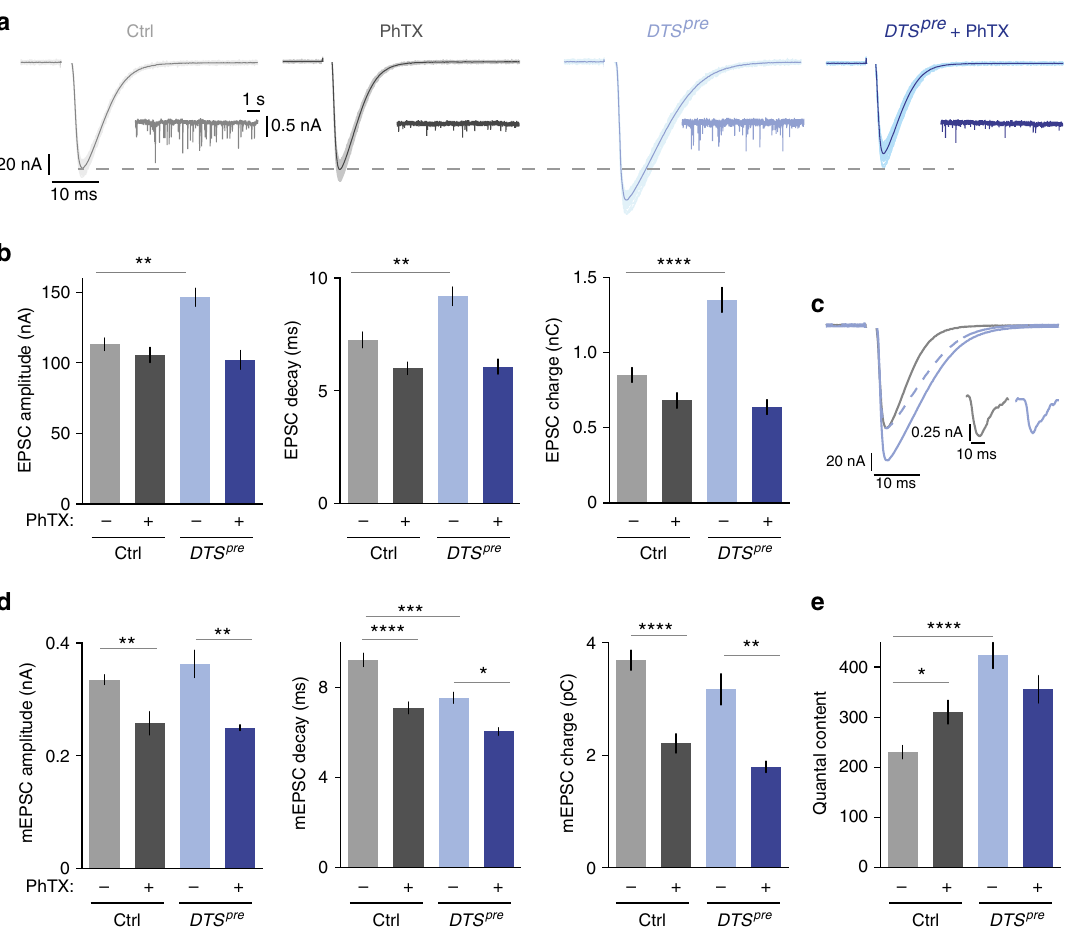
Fig. 4 Presynaptic proteasome perturbation increases EPSC amplitude and decay time. a Two-electrode voltage-clamp recordings of DTS pre mutants and controls with or without PhTX application (20 – 30 µ M; 1 mM [Ca 2+ ] e ). Representative EPSCs (50 sweeps per cell; the average is displayed in darker color; stimulation artifacts have been blanked for clarity) and mEPSCs are shown. b Quanti fi cation of the experiment shown in ( a ). Note that presynaptic proteasome inhibition leads to an increase in EPSC amplitude, decay time constant and charge. Moreover, proteasome inhibition blocks homeostatic plasticity in response to PhTX application. Mean ± s.e.m.; n ≥ 10 cells; ** p < 0.001; **** p < 0.00001; ANOVA and Tukey ’ s multiple comparison tests. c Overlay of an average EPSC of a control cell (gray) and after proteasome inhibition (blue; DTS pre ). The dashed line shows the EPSC for DTS pre normalized to the EPSC amplitude of control. Inset: representative mEPSCs for control and DTS pre . d Quanti fi cation of mEPSC amplitude, decay and charge. Due to technical reasons, mEPSCs were recorded in different cells than EPSCs. Note that the EPSC decay is faster than the mEPSC decay, likely due to partial glutamate receptor desensitization/saturation. Mean ± s.e.m.; n ≥ 6 cells; * p < 0.05, ** p < 0.001; *** p < 0.0001; **** p < 0.00001; ANOVA